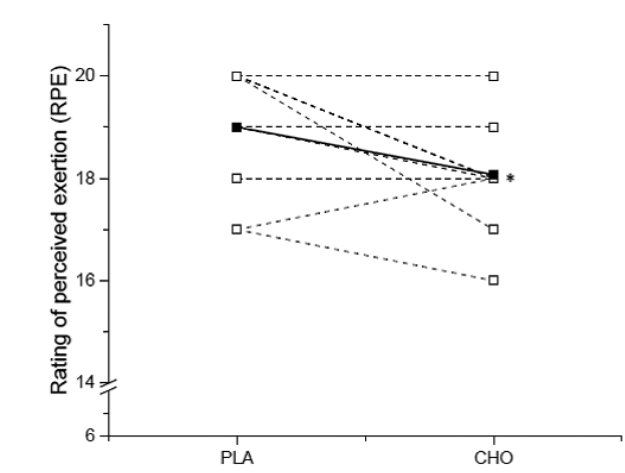
Figure 1. Rating of perceived exertion (RPE) at the moment of exhaustion with CHO and PLA mouth rinse.